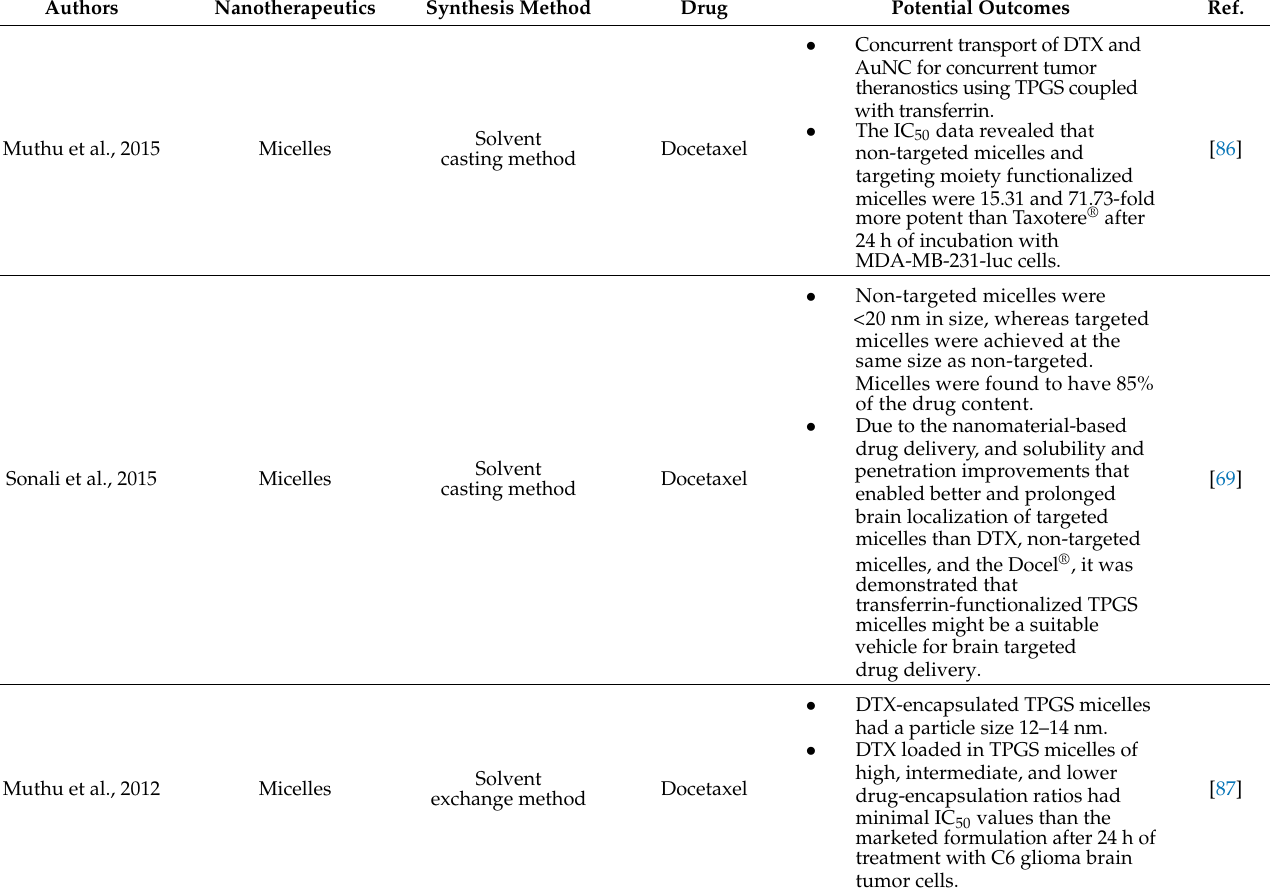
Table 2. Summary of TPGS-based